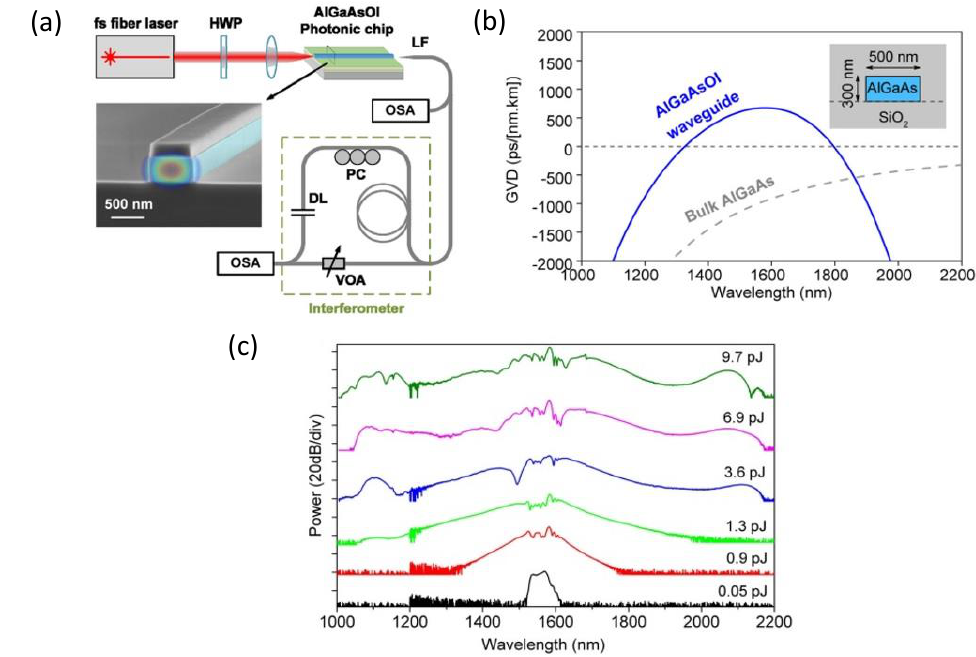
Figure 13. Octave-spanning SCG in AlGaAs-OI platform. ( a ) Schematic of the experimental setup for the spectra measurement. The inset shows an SEM image of the waveguide and the simulated mode profile inside the core. ( b ) Engineered GVD exhibiting anomalous dispersion in the pump wavelength range. ( c ) SCG spectra in AlGaAs-OI waveguide (with the 500-nm width) at different input pulse energies. The 3PA effect causes the saturation of the spectrum broadening with the input pulse power increase. Adapted with permission from [154] ©The Optical